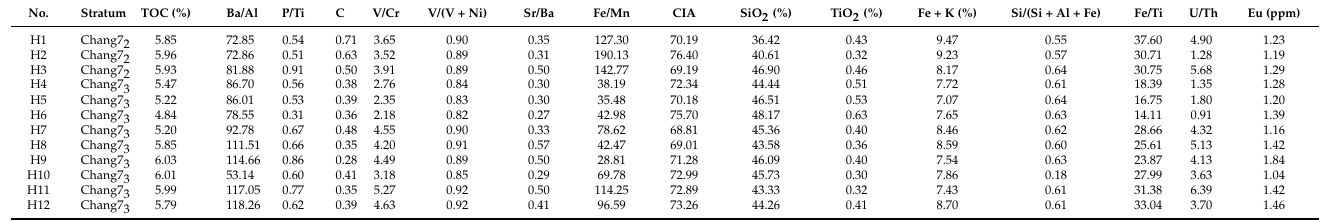
Table 1. The measured values of TOC and major and trace elements in Chang 7 outcrop